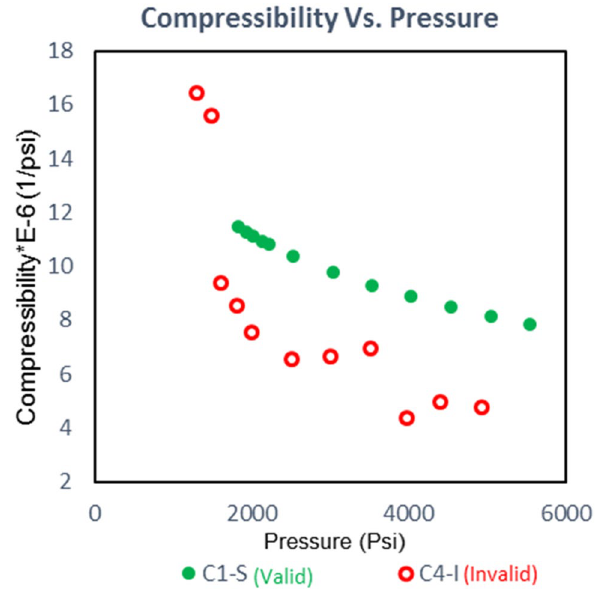
Fig. 11 Valid and invalid trend of oil iso-thermal compressibility fac- tor of BO samples—CCE